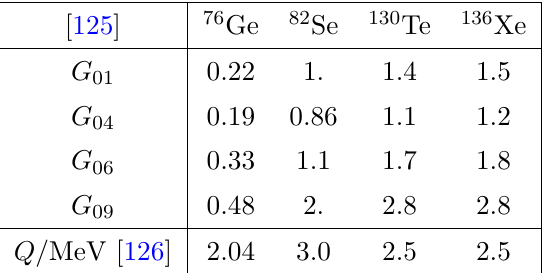
Table 6 . Phase space factors in units of 10 (cid:0) 14 yr (cid:0) 1 obtained in ref. [125]. The last row shows the Q value of 0 (cid:23)(cid:12)(cid:12) for various isotopes, where Q = M i (cid:0) M f (cid:0) 2 m e .